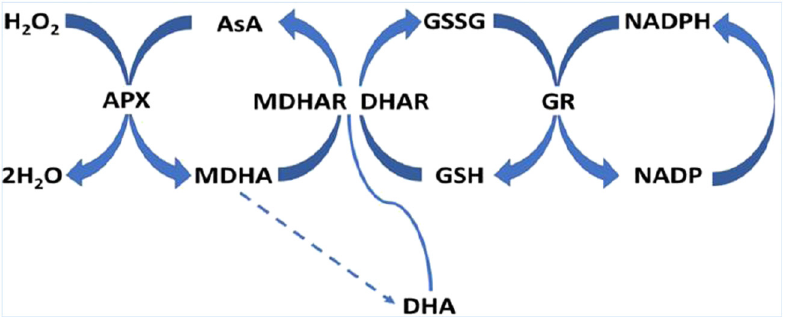
Figure 1: Schematic representation of antioxidant enzymes in the ascorbate – glutathione cycle investigated in this study ( according to Szyma ń ska and Strza ł ka [ 35 ])